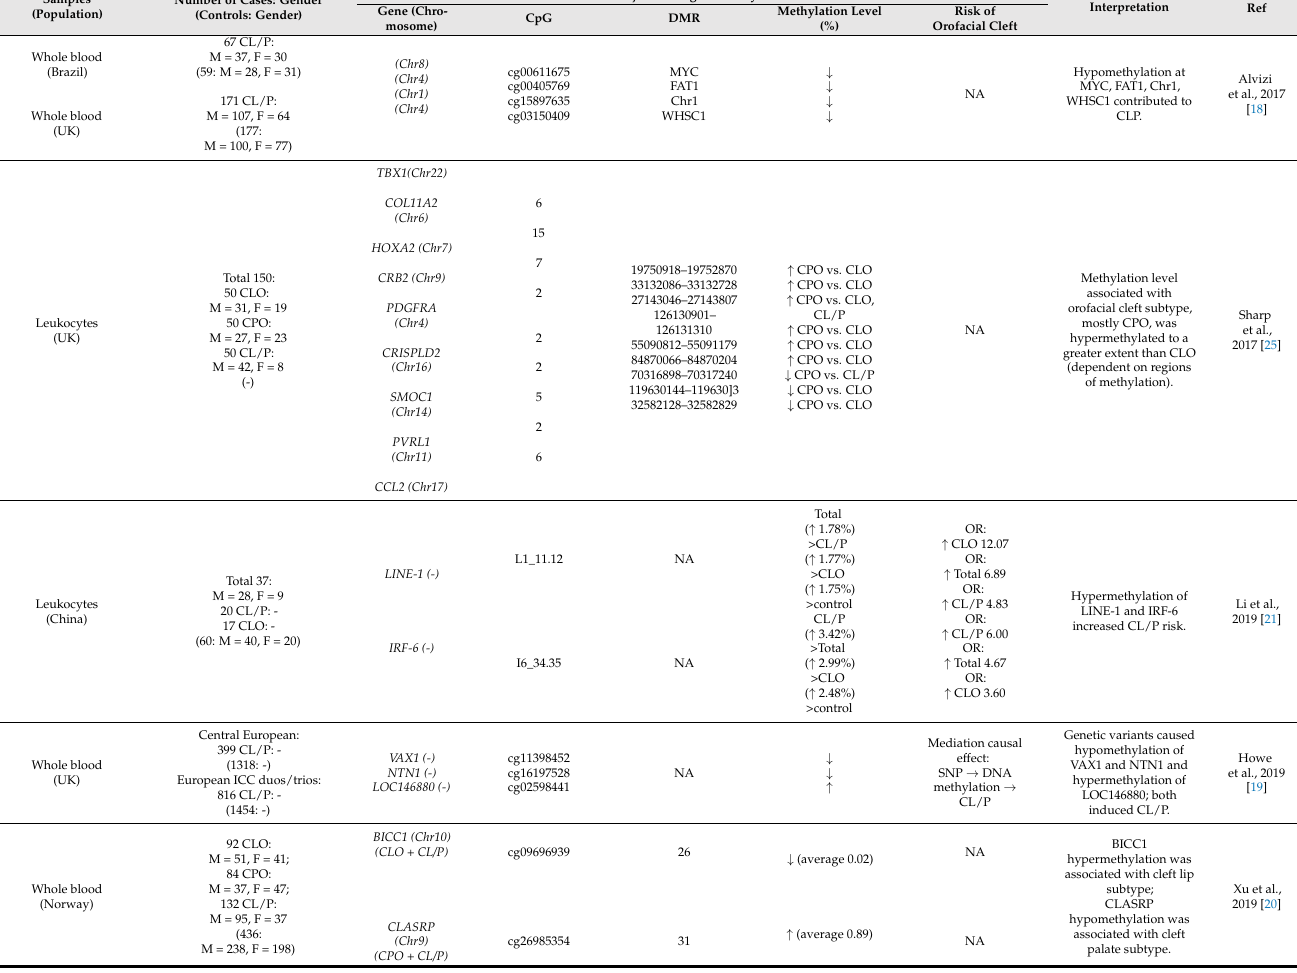
Table 1. Alterations in DNA methylation found in blood samples of patients with an orofacial cleft.